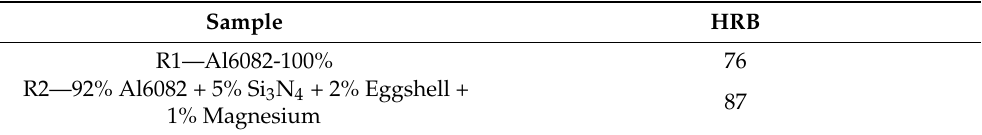
Table 7. Hardness value.